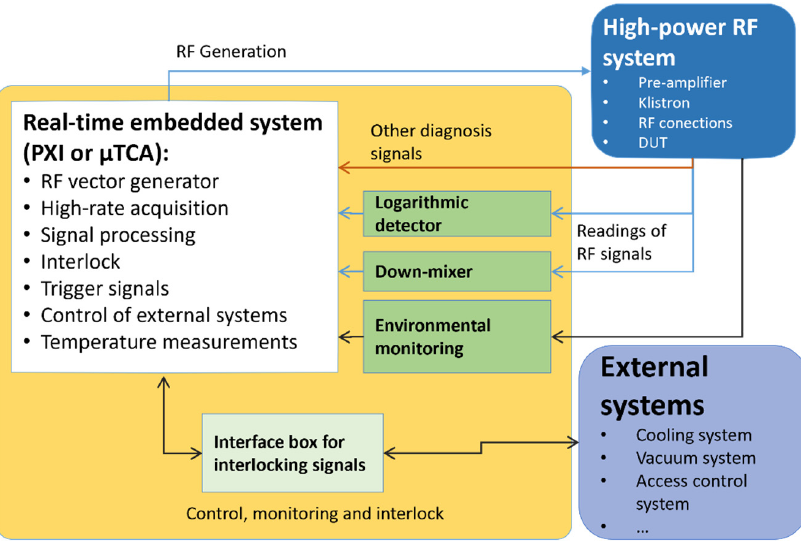
Figure 6. Proposed LLRF control system essential to operate accelerator cavities.